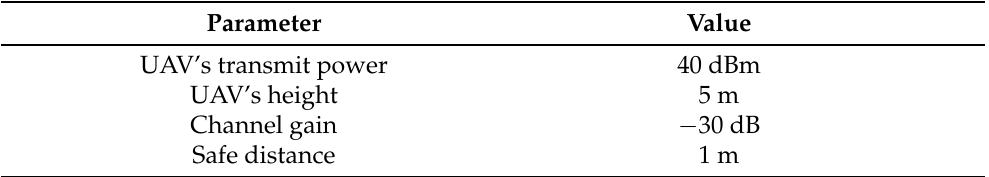
Table 1. Simulation parameters of single-user model.